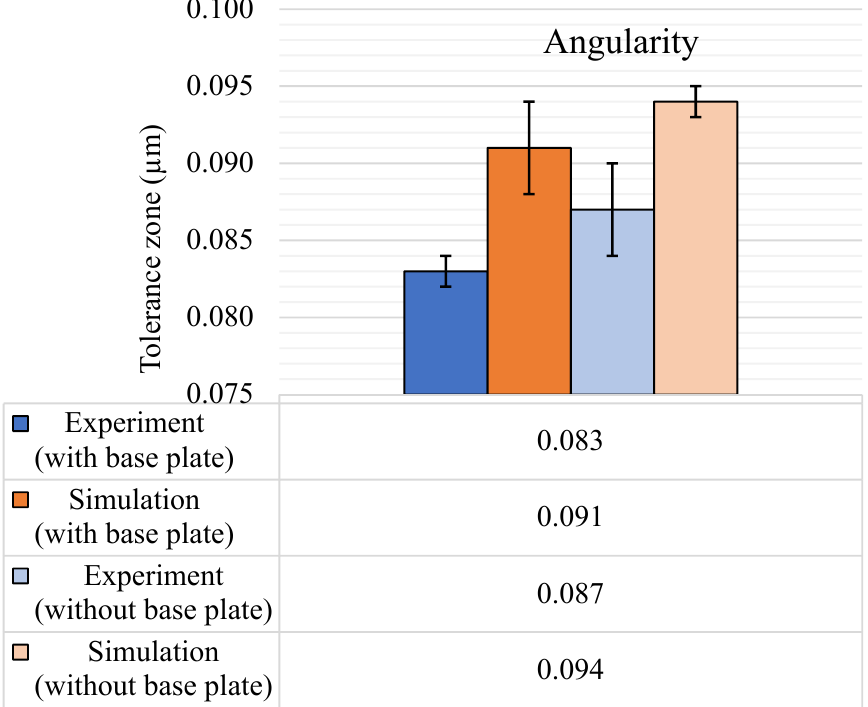
Figure 15. Angularity (µm) tolerance results, with and without the base plate.